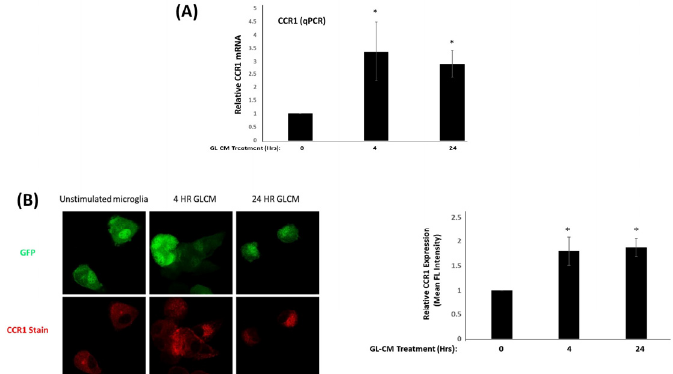
Figure 2. Glioma conditioned media stimulates expression of CCR1 on microglia ( A ) Quantitative PCR of MG cells stimulated with GL261 conditioned media for 4 and 24 h. * p value < 0.05. ( B ) Images and quantitation of immunofluorescence of CCR1 in MG cells stimulated with GL261 conditioned media for 4 and 24 h. * p value < 0.05. Data are means − /+ SEM (n =